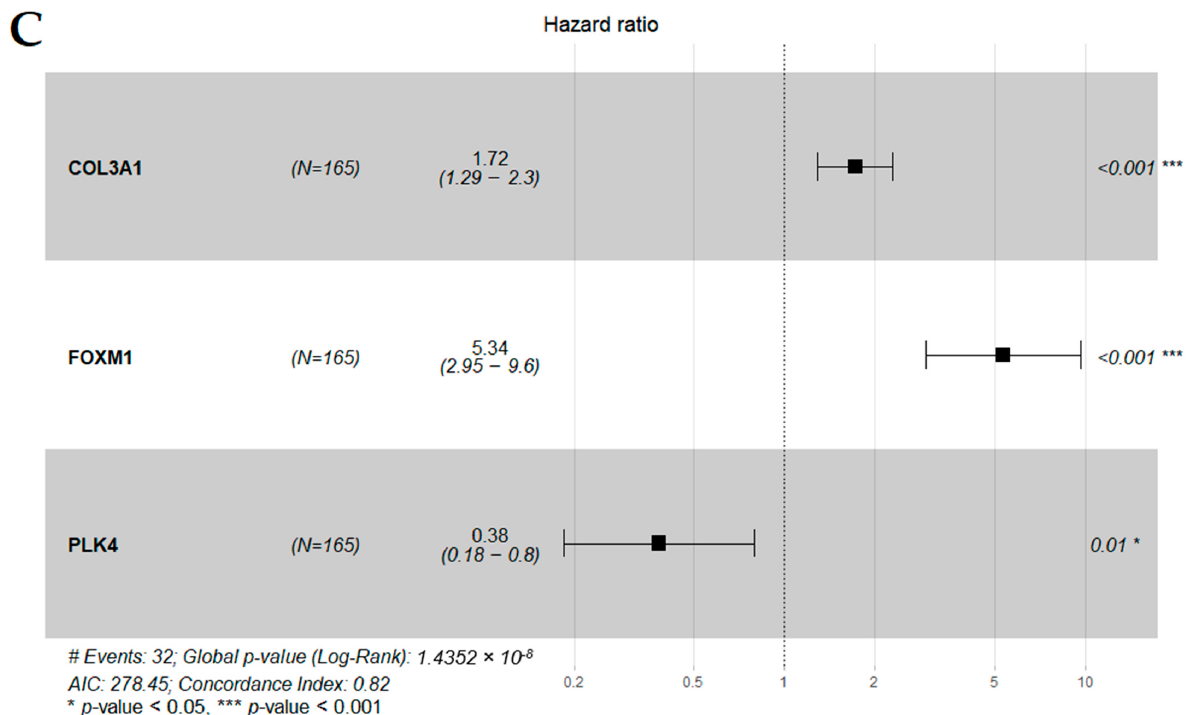
Figure 14. Survival analysis for the GSE13507 ( n = 165) dataset (training set). ( A ) Kaplan–Meier curves for the overall survival of BCa patients as stratified by the three-gene prognostic index. Patients were divided into low- and high-risk groups according to the median prognostic index. ( B ) Time-dependent ROC curves (one-, three-, five-, and ten-year predictions) to assess the prognostic accuracy of the three-gene prognostic model. ( C ) Forest plot for the multivariate Cox regression analysis on the GSE13507. The figure incorporates the hazard ratio value (e coef ) along with the 95% CI and p -value for each